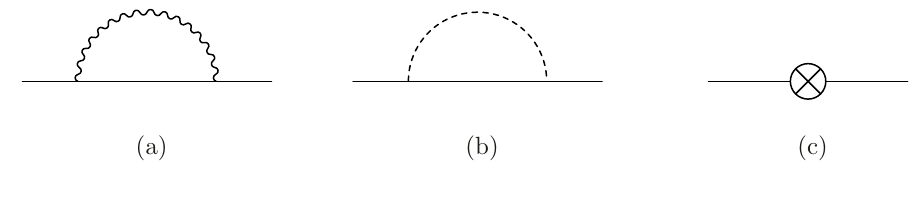
Figure 7. Fermion self-energy